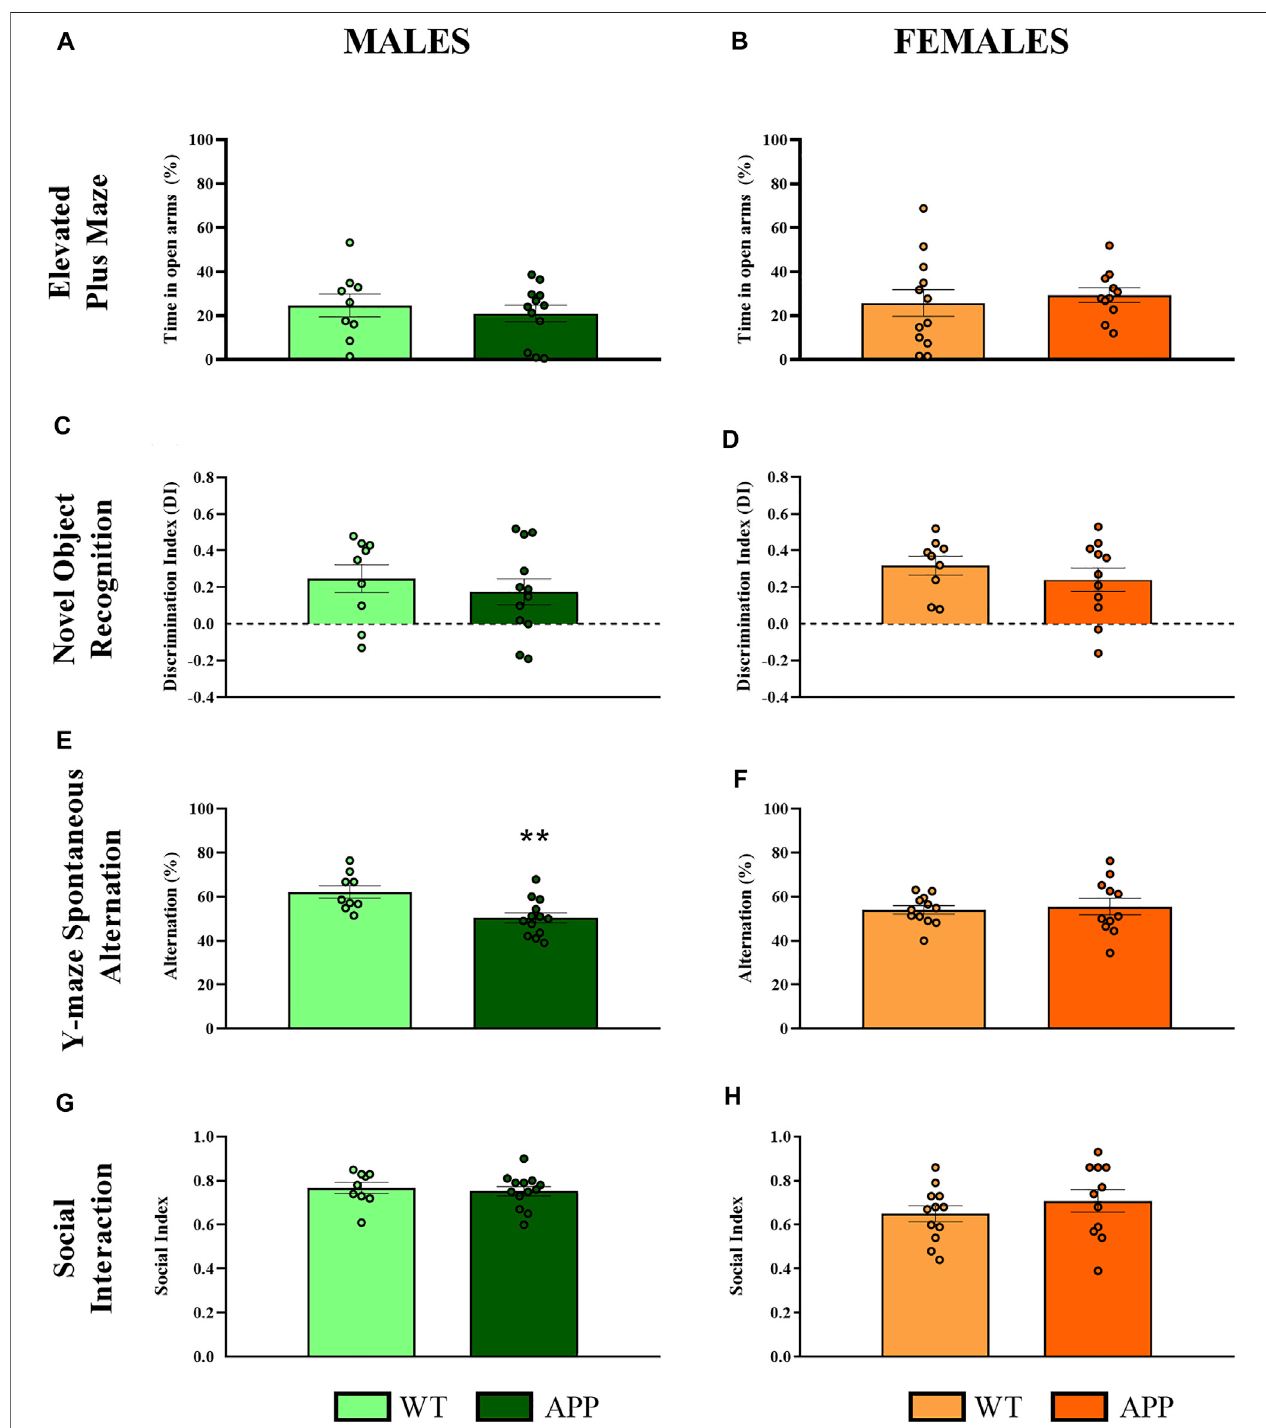
FIGURE 2 | Behavioral evaluation in WT (male n = 9; female n = 12) and APP/PS1 (male n = 13; female n = 11) mice at 4 months of age. (A,B) Percentage of time spent in open arms to assess anxiety-like behavior in the EPM. (C,D) Discrimination index as a long-term memory recognition in the NOR. (E,F) Percentage of spontaneous alternation in the Y-maze as a measure of spatial working memory. (G,H) Social index as a measure of social interaction using the three-chamber test. Values are the mean ± SEM. ** p < 0.01 vs. WT group (one-way ANOVA).